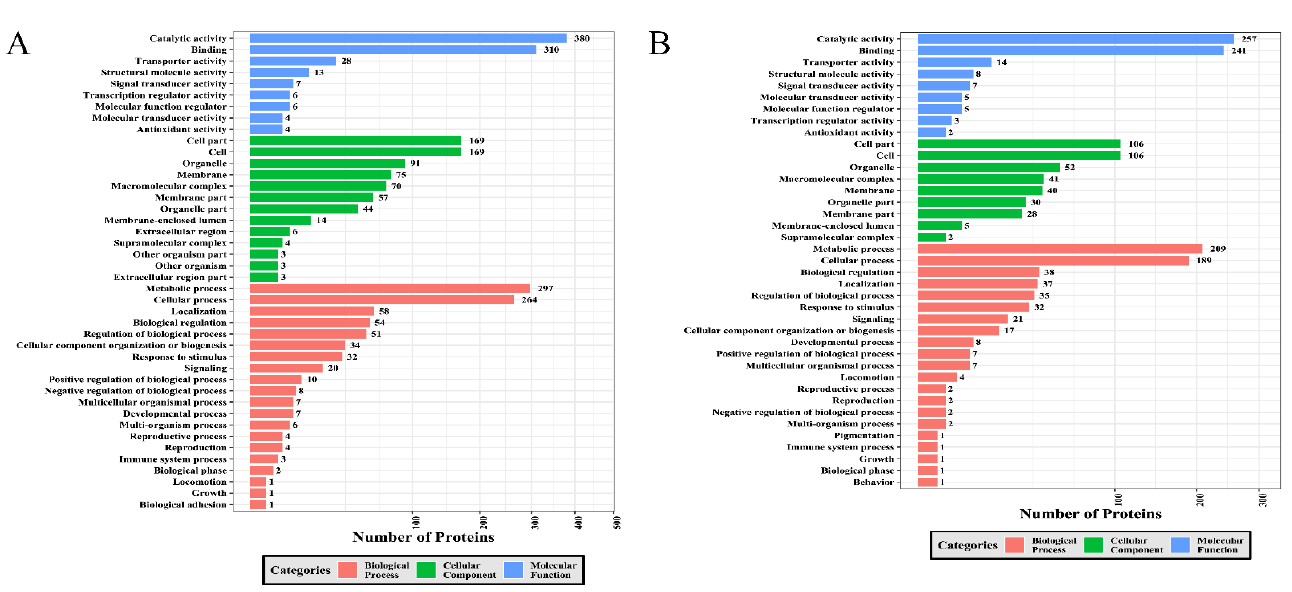
Figure 7. GO enrichment analysis of DEPs. ( A ) GO enrichment analysis of upregulated DEPs. ( B ) GO enrichment analysis of downregulated DEPs. The number of DEPs and GO terms are displayed on the horizontal axis and vertical axis, respectively.